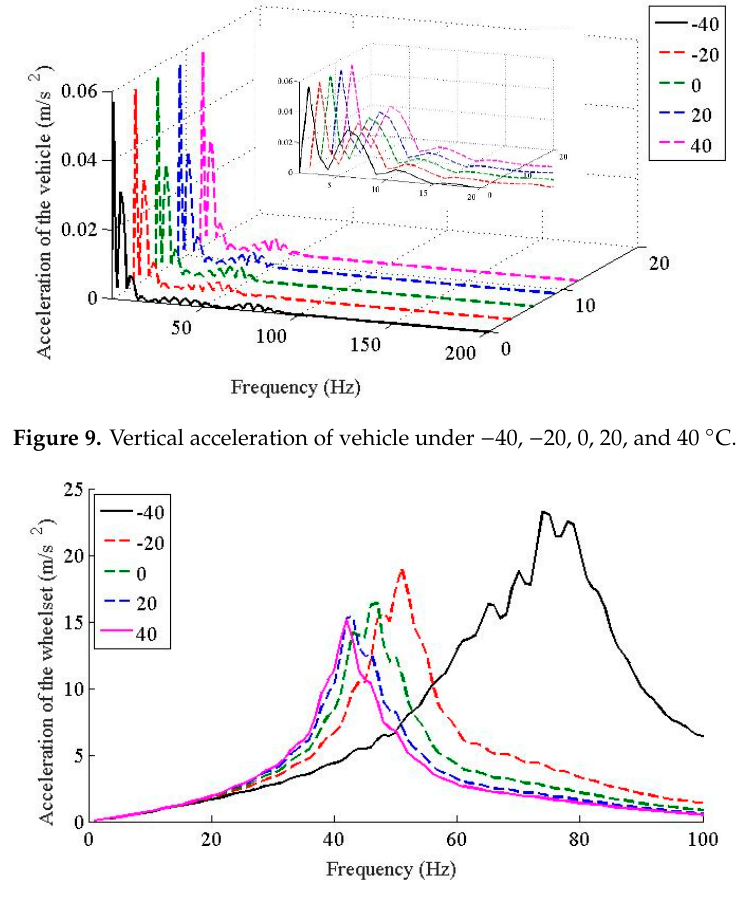
Figure 10. Vertical acceleration of the wheelset under − 40, − 20, 0, 20, and 40 ◦ C.